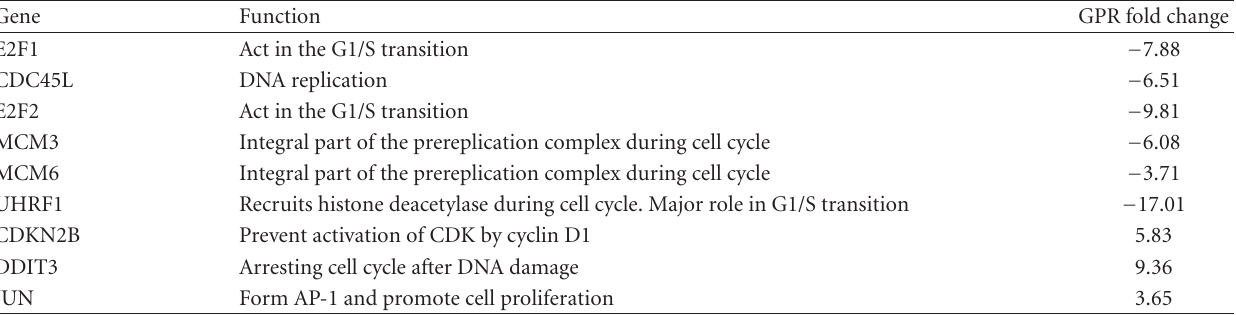
Table 3: Significant GPR fold change in the mRNA of target genes related to cell cycle in IGF-1 + auraptene treated cells compared to cells treated with IGF-1 alone at 8